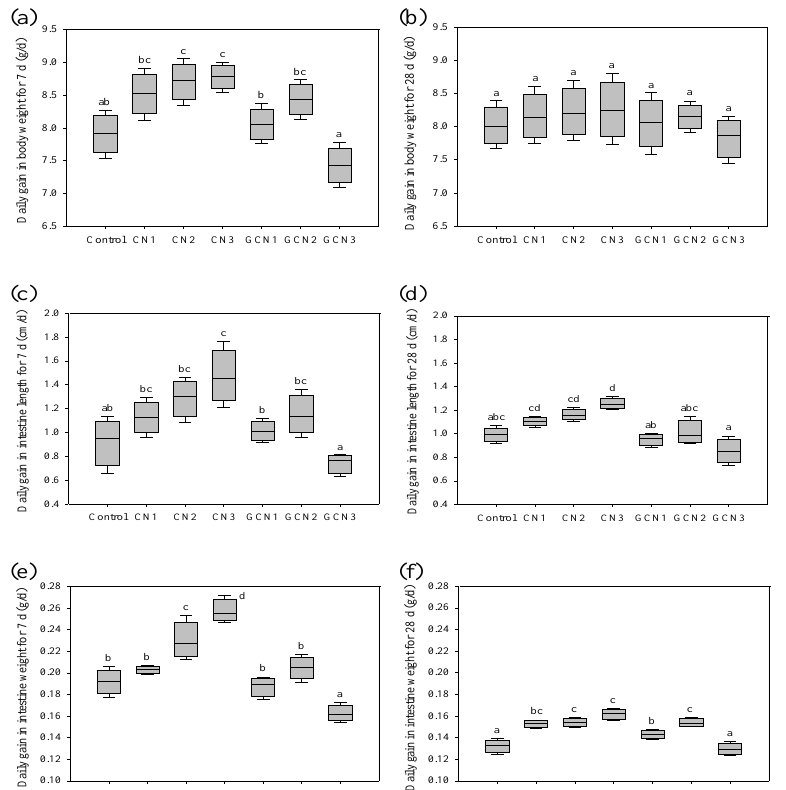
Figure 1. Effects of caseinate digest and glycated caseinate digest on daily gain in BW for 7 or 28 d ( a , b ), intestine length for 7 or 28 d ( c , d ), and intestine weight for 7 or 28 d ( e , f ). Values are reported as means ± standard deviations ( n = 6), while different lowercase letters above the columns indicate that one-way ANOVA of the means differs significantly ( p < 0.05). CN: caseinate; GCN: glycated caseinate; control: rats fed with 0.9% NaCl; CN1, CN2, and CN3: rats fed with 100, 200, and 400 mg/kg BW/d of CN digest, respectively; GCN1, GCN2, and GCN3: rats fed with 100, 200, and 400 mg/kg BW/d of GCN digest,